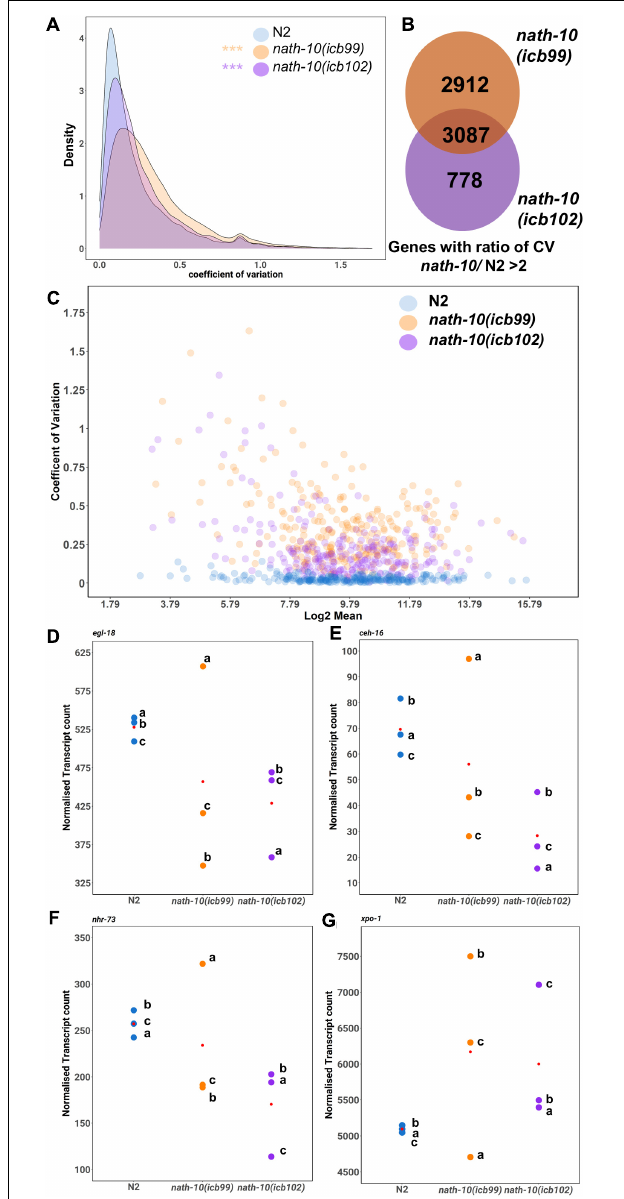
FIGURE 4 | RNA-seq analysis reveals changes in transcript variance at the population level. (A) Density plots of coefficient of variation (CV) in nath-10 mutants and N2. Both nath-10 alleles show significant change in the distribution of the coefficient of variation compared to N2, with a trend toward an increase in transcript variability (Kolmogorov-Smirnov test, ***p < 0.001). (B ) Venn diagram displaying the overlap of genes that display a > 2 ratio of CV when compared to N2 for nath-10 ( icb99) and nath-10(icb102) mutants. Both alleles show a 50% overlap of the most variable genes and this overlap includes core seam cell transcription factors ceh-16 , egl-18, and nhr-73. (C) Coefficient of variation plotted against the log2 normalized transcript counts from RNA-seq analysis for seam cell-enriched genes in nath-10 alleles and wild type. (D–G) Normalized transcript counts plotted per replicate (a, b, c) for N2, nath-10(icb99) and nath-10(icb102) showing egl-18 , ceh-16 , nhr-73 and xpo-1 expression. Note that both nath-10 alleles display a great spread of normalized transcript count compared to the N2 replicates and the variance is not driven consistently by the same replicate for each